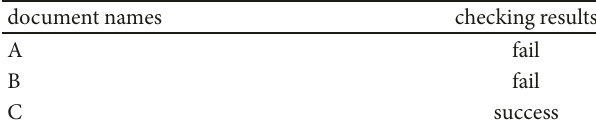
Table 2: File integrity check